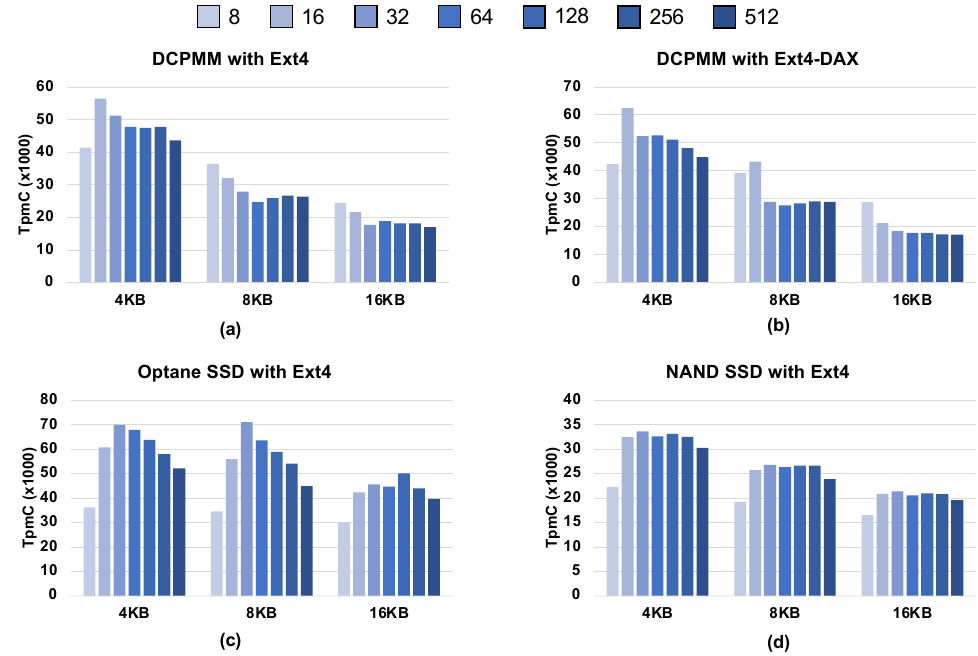
Figure 6. TPC-C results on DCPMMs ( a , b ), Optane SSDs ( c ), and NAND SSDs ( d ). The InnoDB page size varies from 4 KB to 16 KB. The number of connected clients varies from 8 to